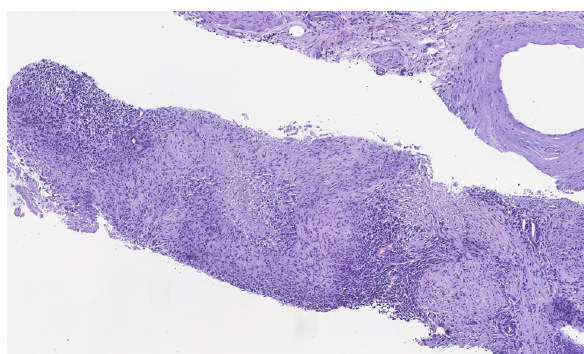
Figure 3 - H&E-stained slide (10x) from a prostate needle core biopsy with granulomatous prostatitis showing epithelioid cells, multinucleated giant cells and lymphocyte